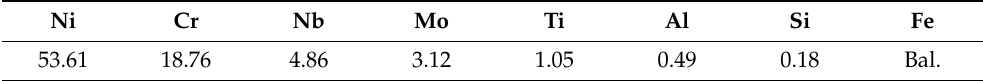
Table 1. Chemical composition of the Ti6Al4V alloy wire (mass fraction, %).